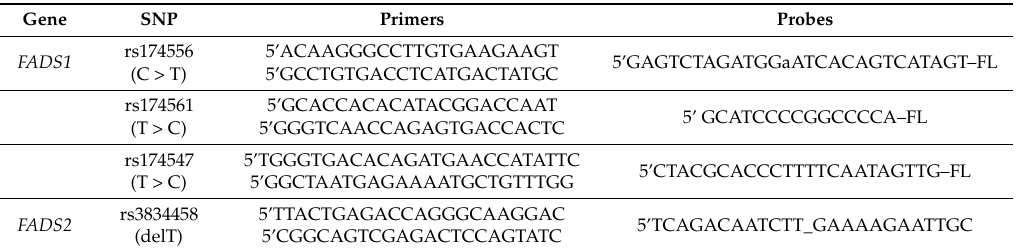
Table 1. Primer and probe sequences used in the FADS genotyping